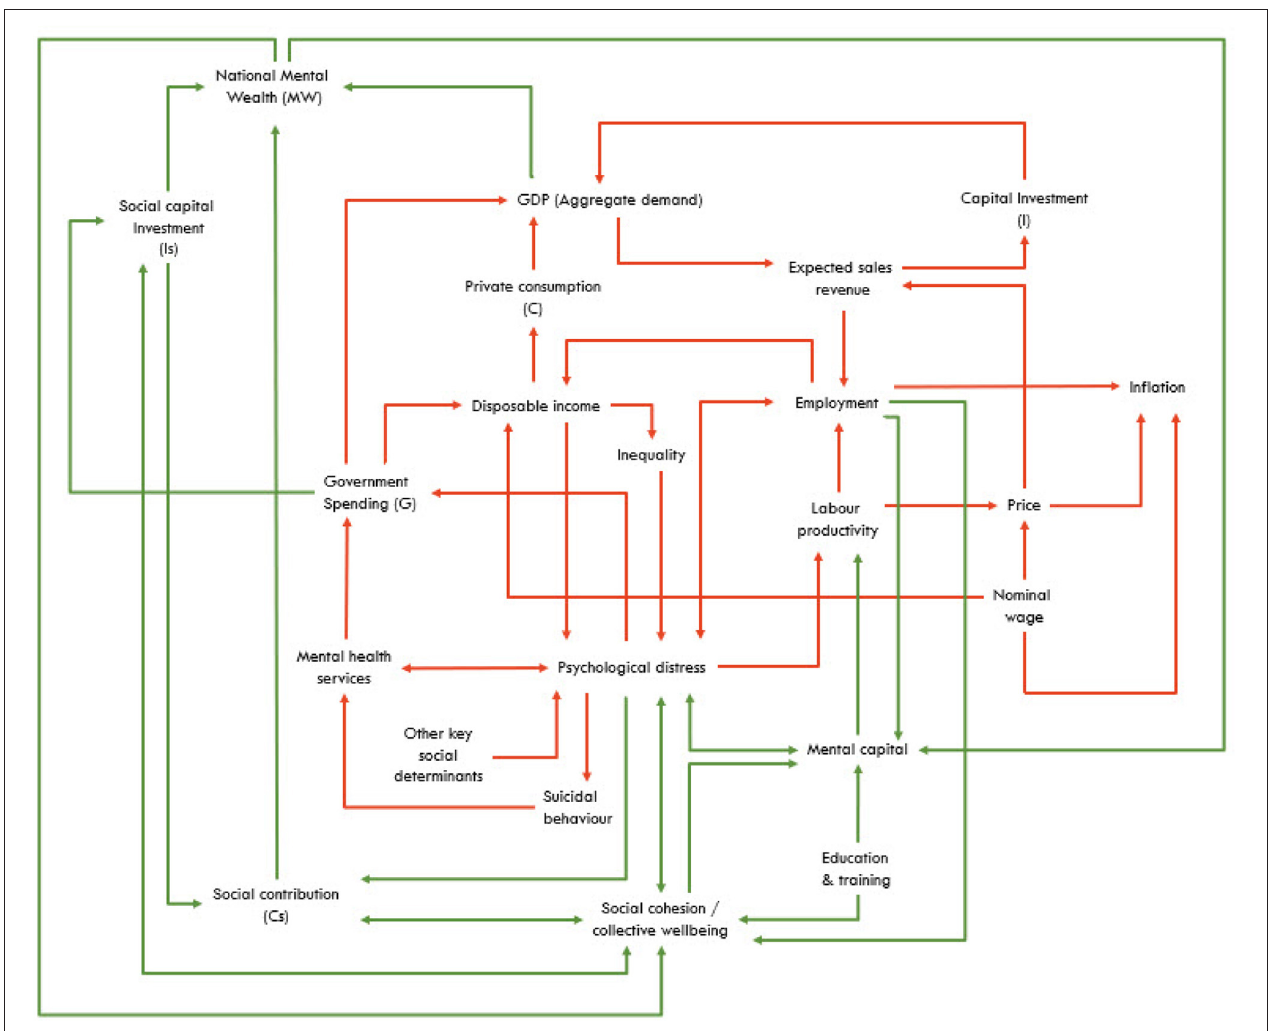
FIGURE 3 | A high-level overview of the hypothesized (macro) causal structure and pathways of the proposed dynamic Mental Wealth model. Arrow colors reflect Phase 1 (red) and Phase 2 (green) of model development.